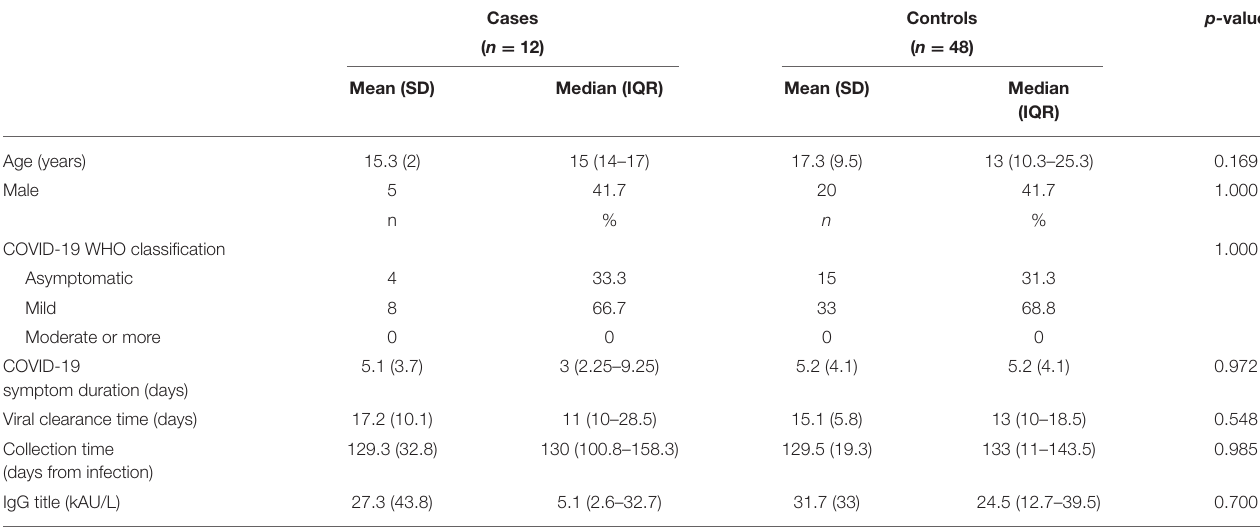
TABLE 2 | Demographics, COVID-19 clinical and serological features of pediatric IBD patients vs. healthy children with SARS-CoV-2 infection. Cases Controls p-